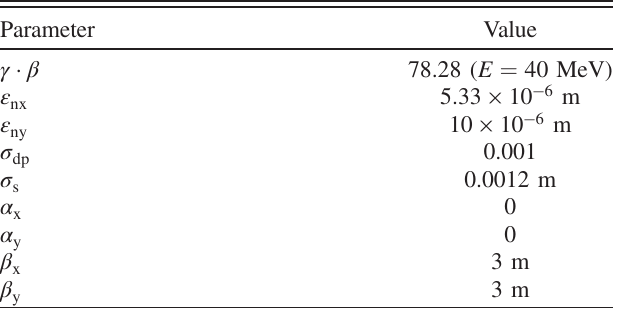
TABLE II. Parameters of the Gaussian electron beam used in Elegant